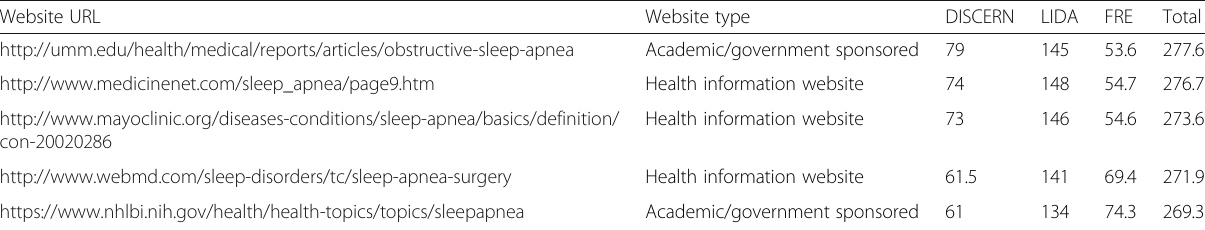
Table 1 Top 5 websites in terms of aggregate total DISCERN, LIDA, and FRE scores Website URL Website